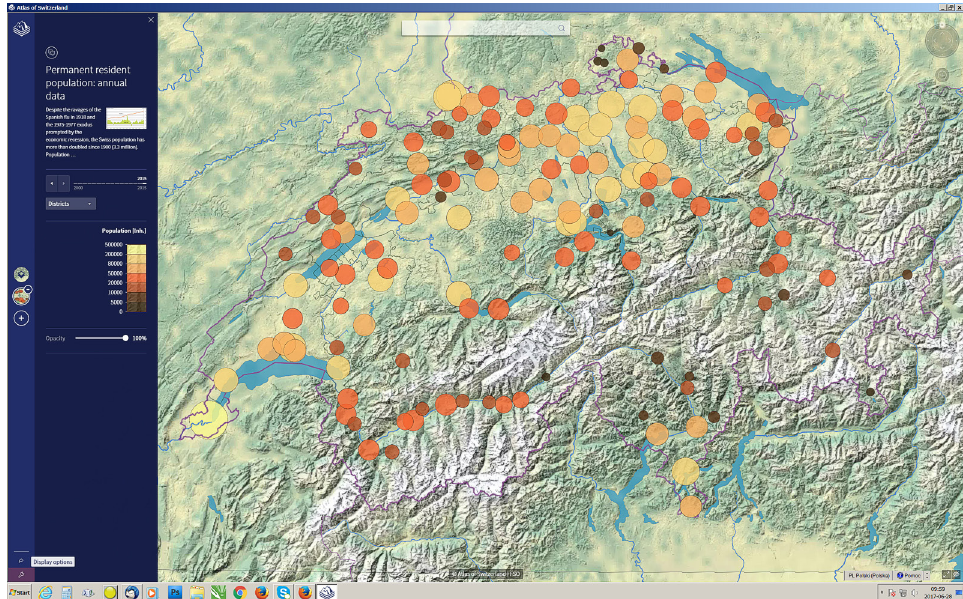
Fig. 3. Map of the population distribution of Switzerland in 2015 as an example of excessive exposure of base contents (source: Atlas of Switzerland,